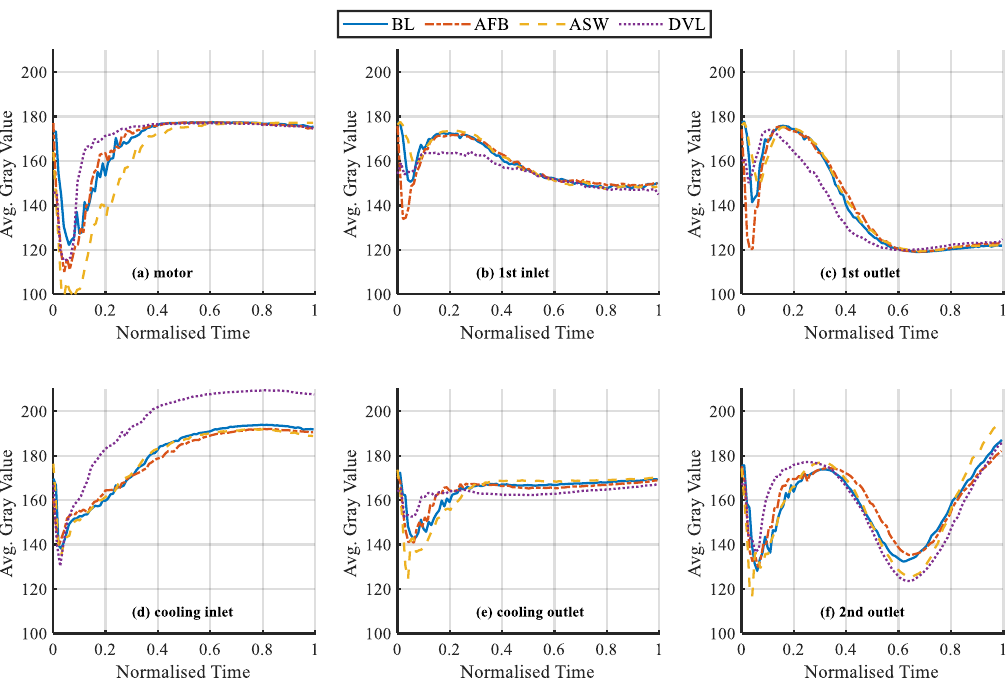
Figure 6. The average grayscale value of the six regions under different working conditions in which the variation process is normalized by operating time ( a – d ).